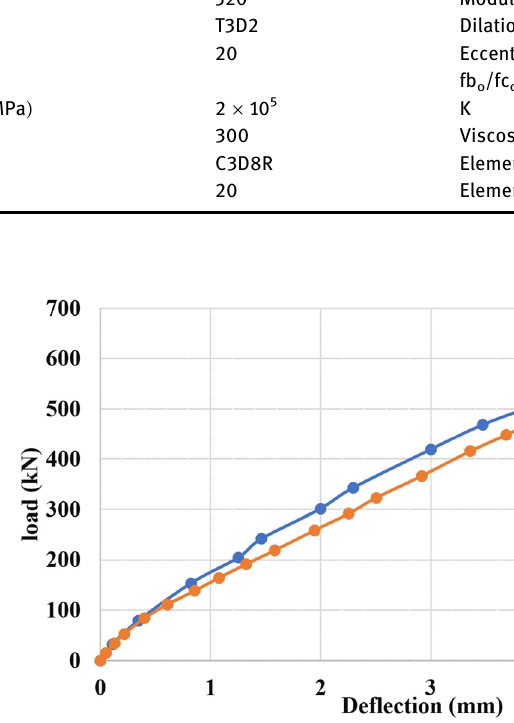
Figure 7: Load – de fl ection curve of the experimental and numerical sample ( BC2 )